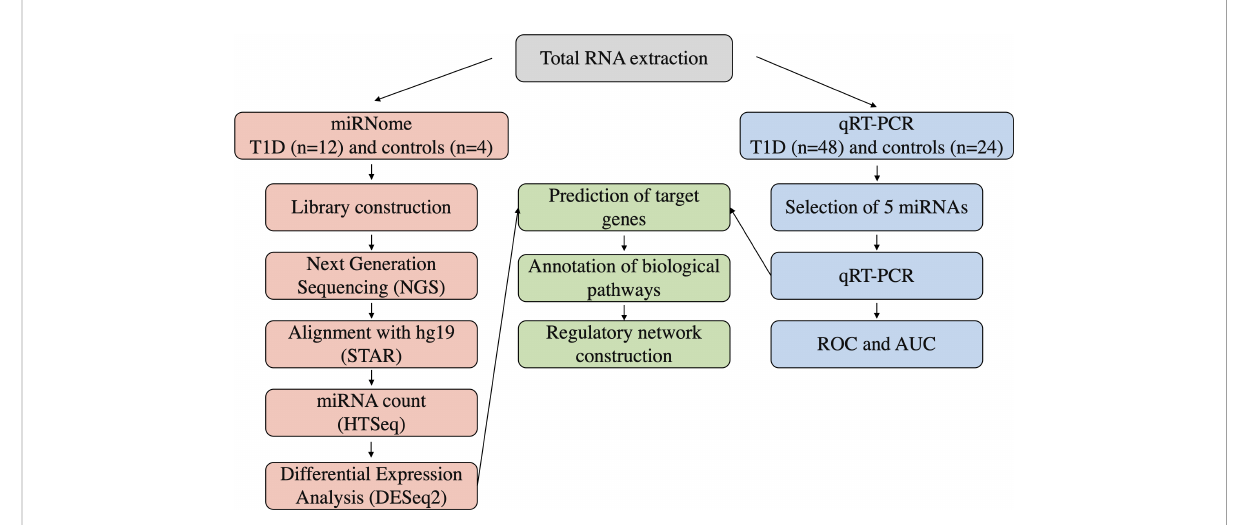
FIGURE 1 Experimental work fl ow of the analyses in the